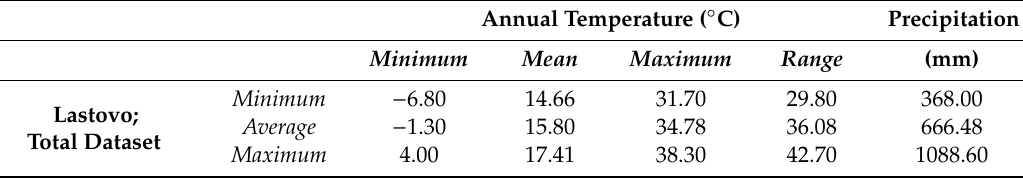
Table 3. Statistics (minimum, average, and maximum) of the annual minimum, mean, and maximum air temperature and of the annual cumulative precipitation at the analyzed stations. The range of the annual air temperature was calculated subtracting the minimum annual temperature from the maximum annual temperature. The total dataset includes all available data. The contemporaneous temperature dataset spans from 1958 to 2018 (missing 1964–1965, 1975, 1982–1985, 1993–1997, and 2011), while the contemporaneous precipitation dataset spans from 1963 to 2018 (missing 1971, 1982–1986, 1990–1998, 2000–2001, and